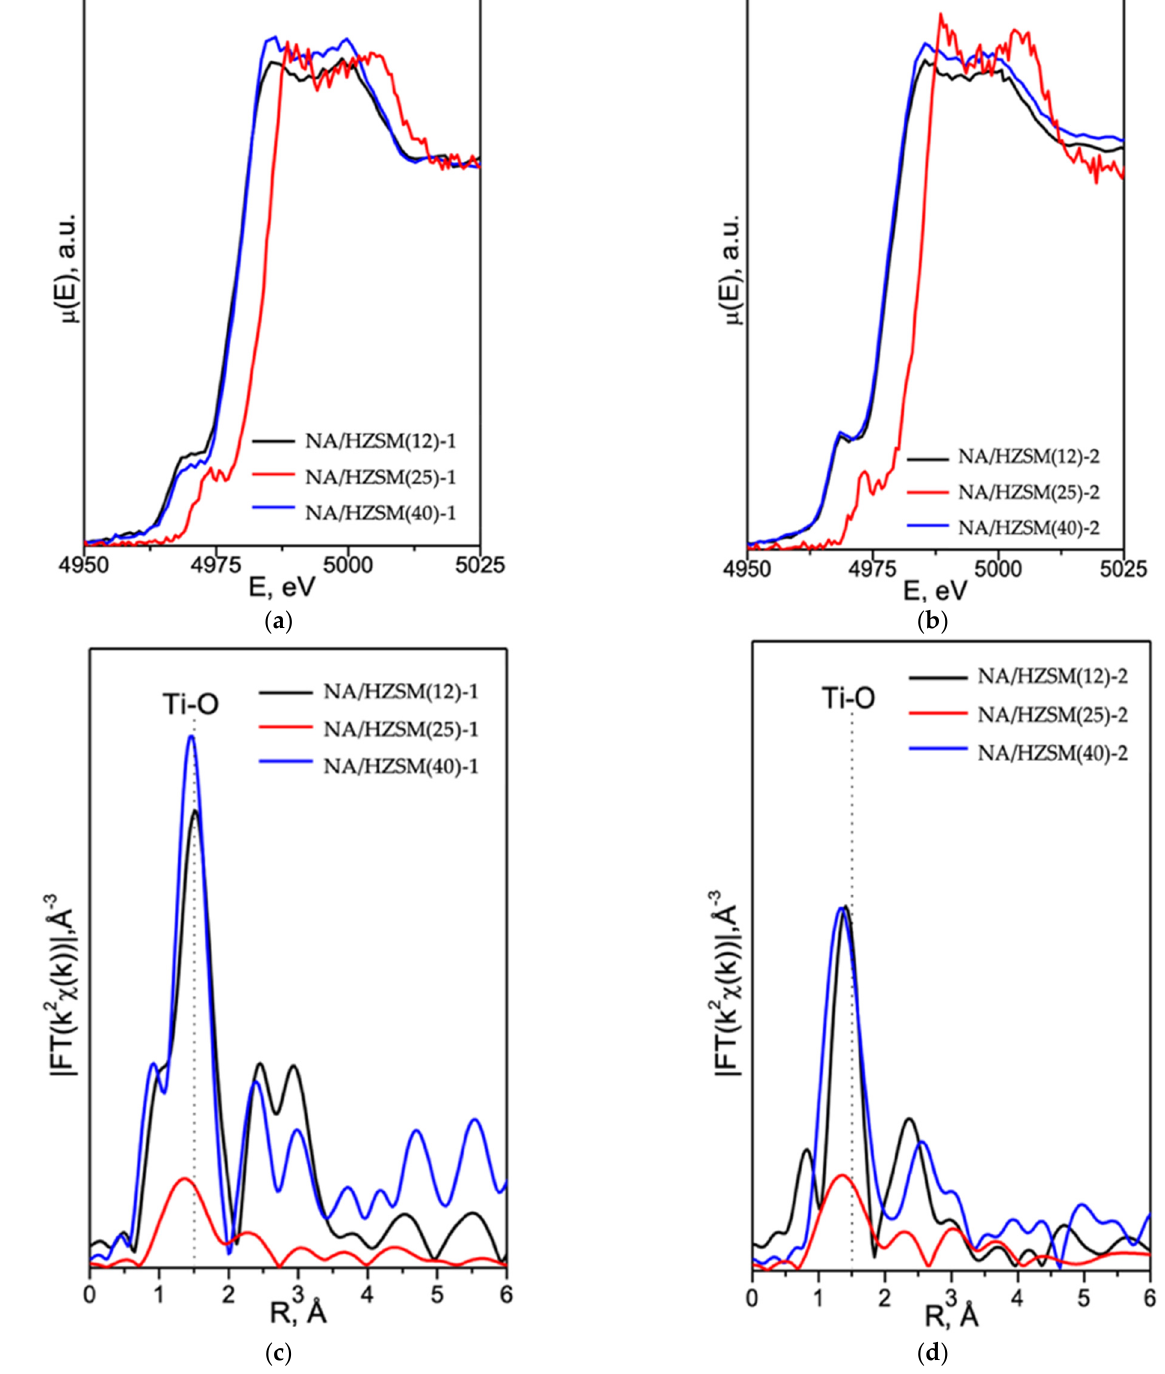
Figure 8. Ti K-edge XANES ( a , b ) and EXAFS ( c , d ) data for NA/HZSM-1, NA/HZSM-2 composites (adapted from [16]). In the EXAFS Fourier transforms (Figure 8c,d), the most intense peak at R ~1.5 Å corresponds to the Ti atoms oxygen environment. The results of the simplest EXAFS simulation (single Ti-O scattering path) are shown in Table 6.